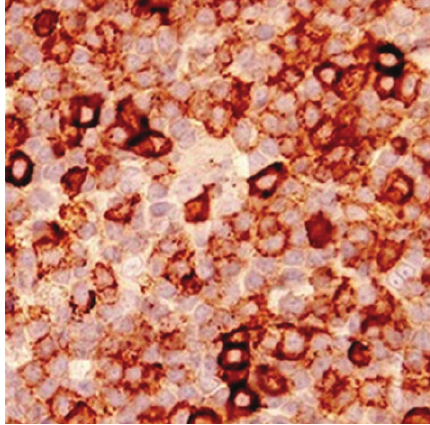
Figure 4: Positive immunohistochemical staining for